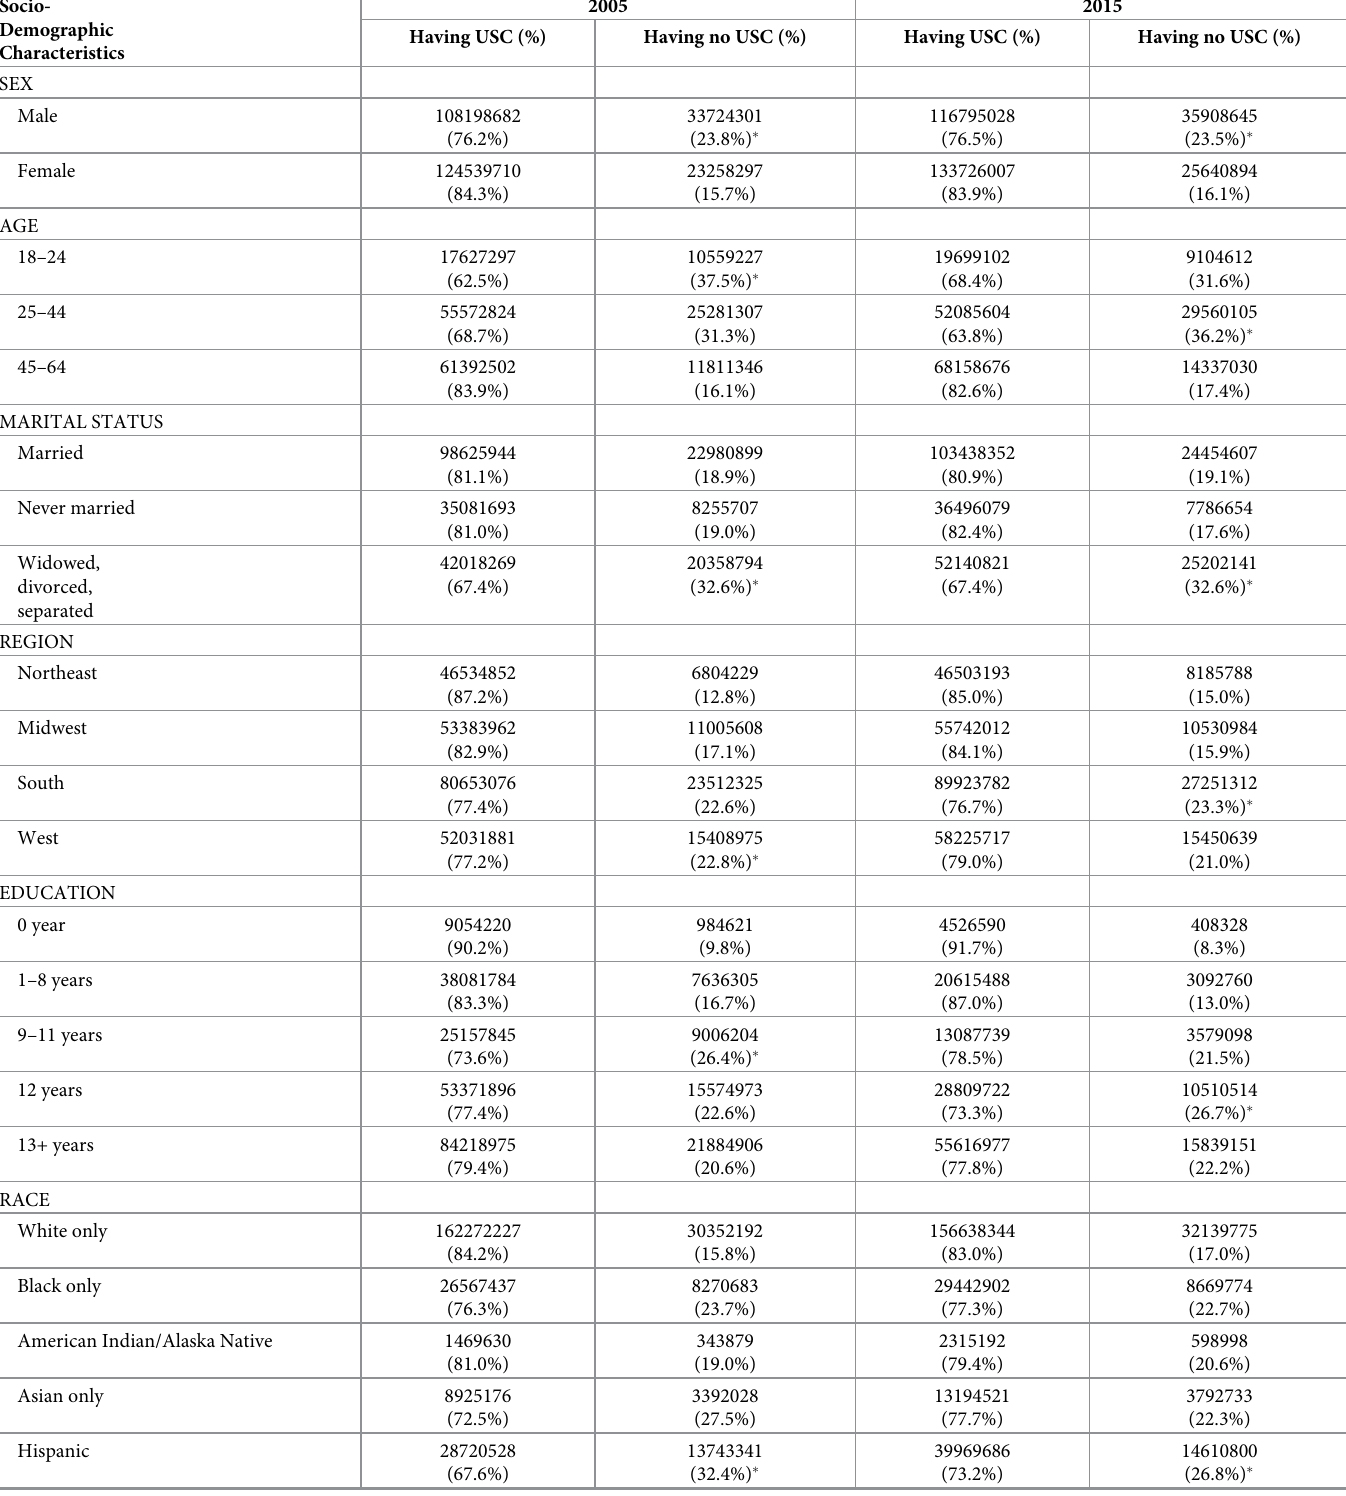
Table 2. Usual source of care by sociodemographic characteristics: 2005 vs.